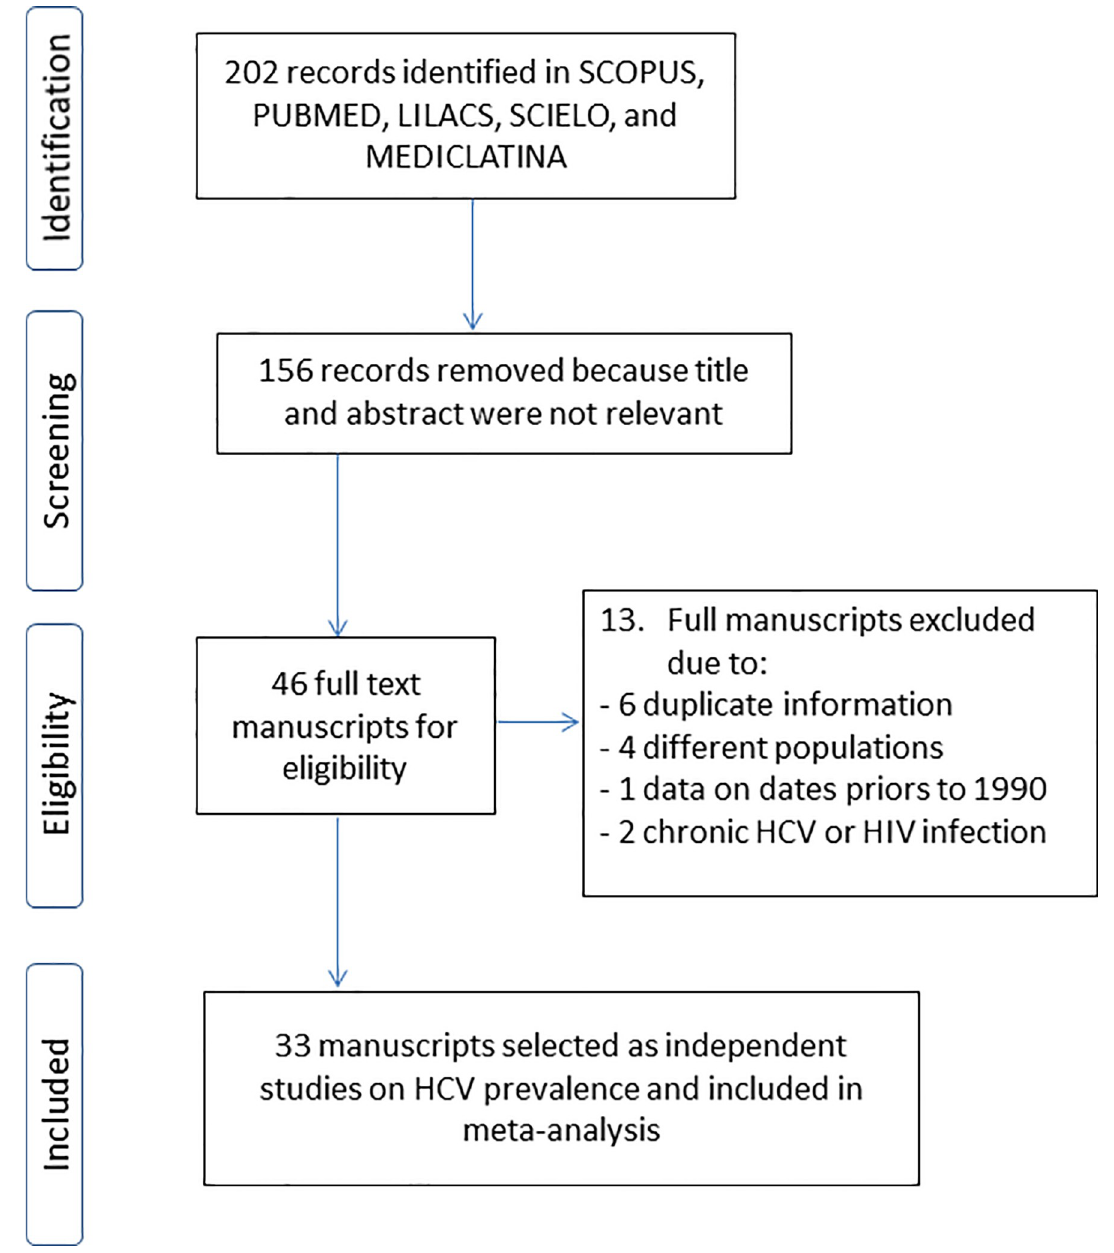
Fig 1. Search results and studies included in systematic review and